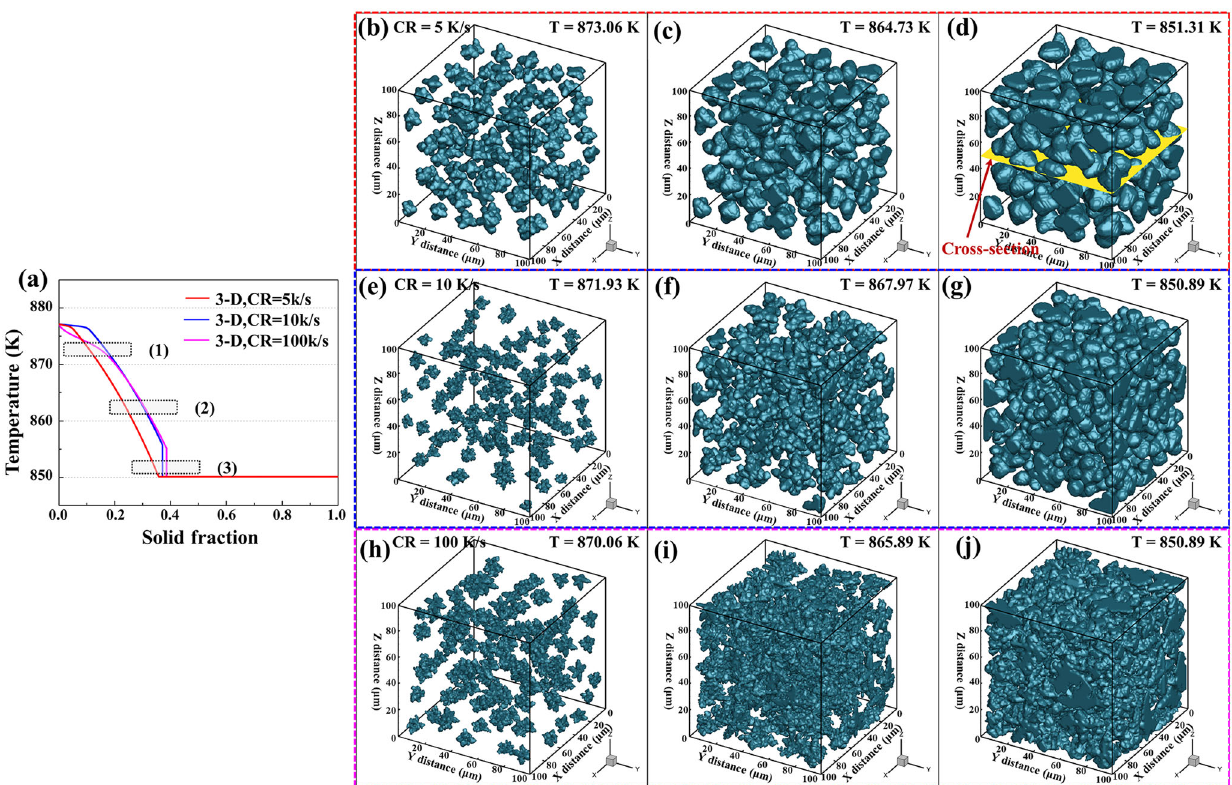
Fig. 2 3-D multi-dendrite morphology. 3-D multi-dendrite morphology with different cooling rates: a Solid fraction as a function of temperature obtained by 3-D multi-dendrite morphology with the cooling rate of 5 K s − 1 at b 873.06 K, c 864.73 K, and d 851.31 K, 10 K s − 1 at